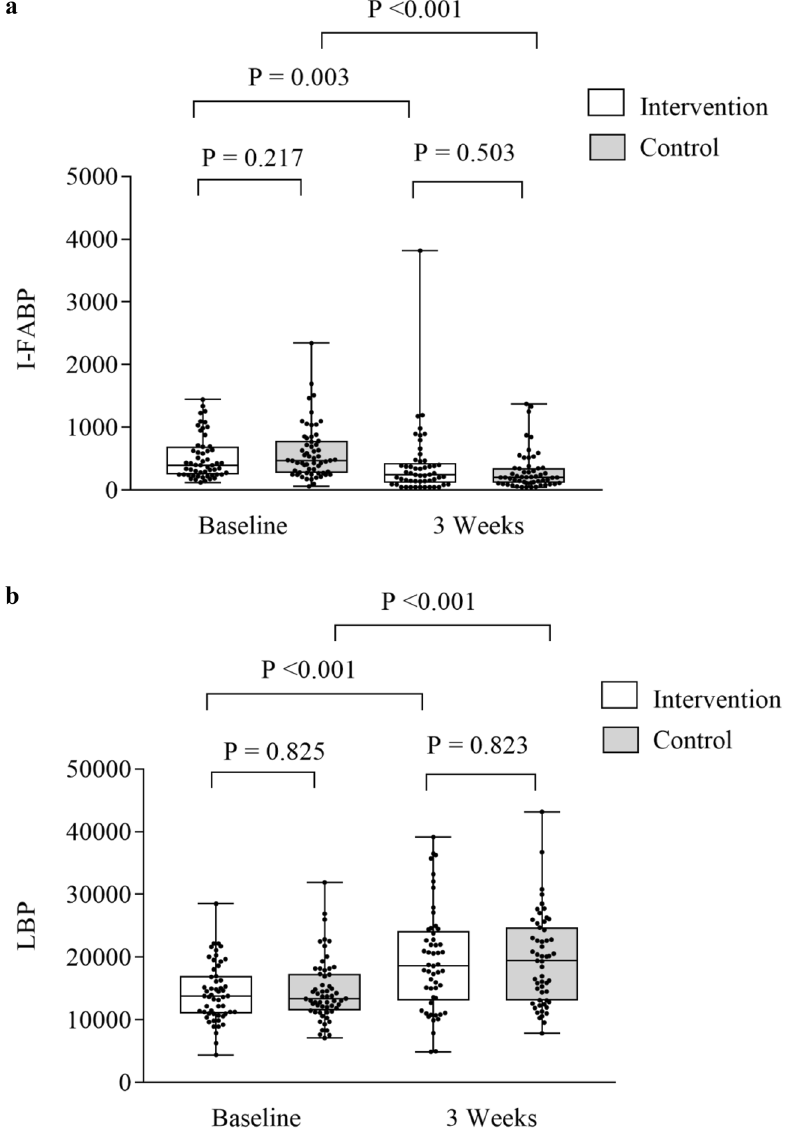
Figure 3. Markers of gut barrier functions and the intervention and control group at baseline and 3 weeks. ( a ) Intestinal fatty acid binding protein (I-FABP) and groups, ( b ) lipopolysaccharide binding protein (LBP) and groups. Data are I-FABP and LBP given as individual values (dots) and box plots (median and interquartile range) with minimum and maximum